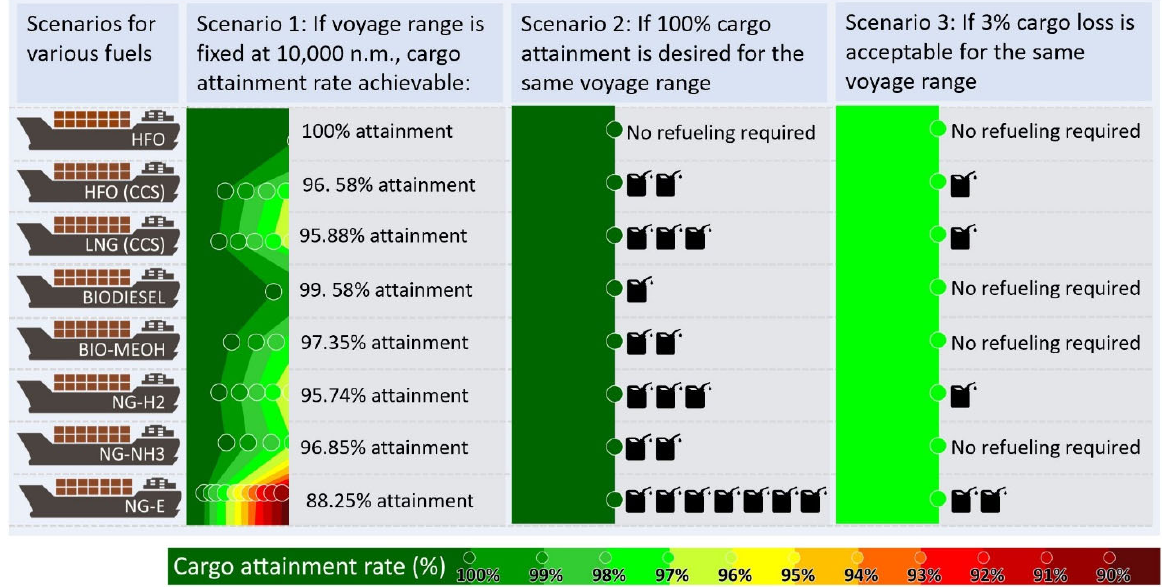
Figure 11. Cargo attainment rate for various alternative fuels against voyage distance, for ships carrying 1.25 m 3 /ton. The reference is an HFO ‐ fuelled containership carrying 1.25 m 3 /ton for 10,000 nm.